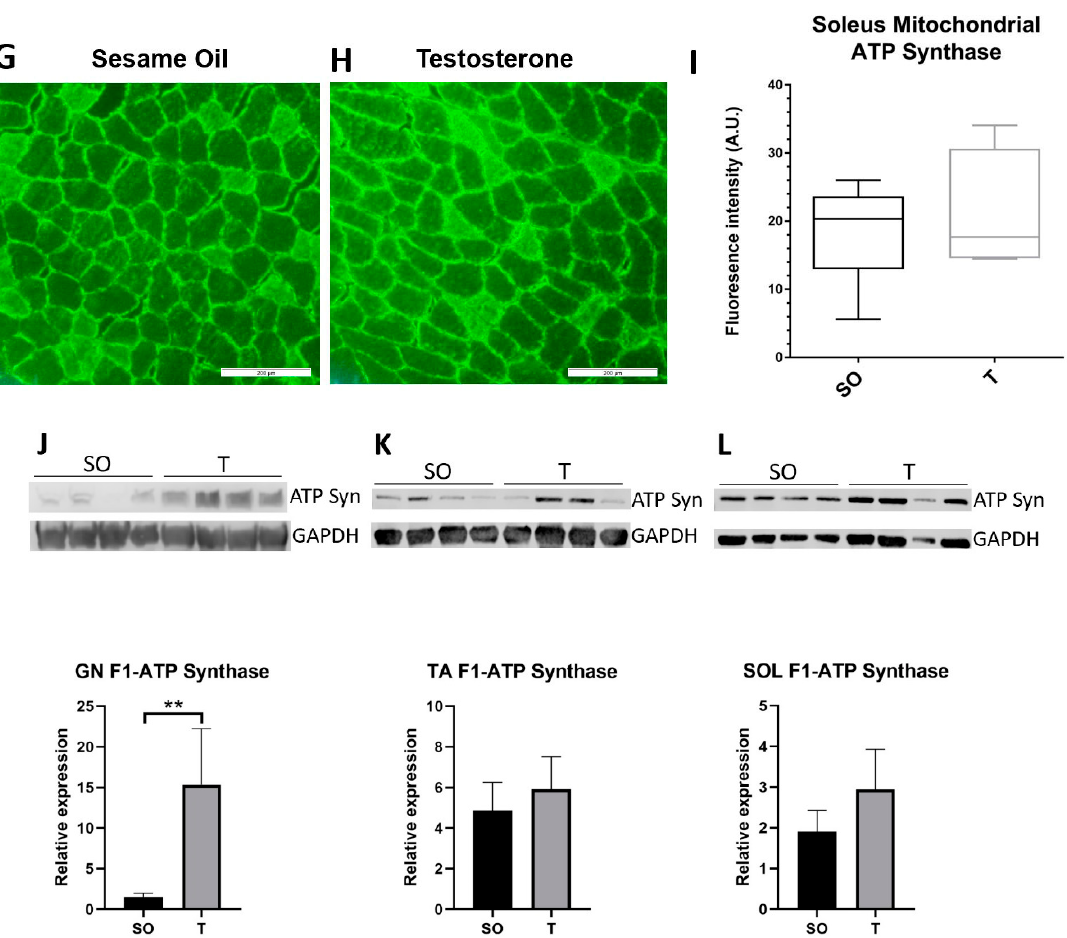
Figure 6. Expression of the mitochondrial marker ATP synthase is higher in gastrocnemius muscle in PNA rats. Gastrocnemius ( A – C ), tibialis anterior ( D – F ), and soleus ( G – I ) skeletal muscles from 16-week-old female rats exposed to sesame oil ( n = 4–5) or testosterone ( n = 4–5) were cryosectioned at 20 µm thickness prior to indirect immunolabeling for ATP synthase. Scale bars, 200 µm. For each rat, 3 distinct fields per muscle sample were imaged and the fluorescence intensity quantified ( C , F , I ). Fluorescence intensity data were analyzed using a Mann–Whitney U test. Fluorescence intensity trended higher in muscles from PNA rats for gastrocnemius (# p = 0.0556), trended slightly lower in TA (# p = 0.0979), but was not significantly different in soleus muscle. Quartiles with the median are shown. ( J – L ) Protein expression was examined by Western blot and quantified by densitometric analysis. Samples of ( J ) GN, ( K ) TA, and ( L ) SOL muscles from rats exposed to sesame oil ( n = 8) or testosterone ( n = 8) were separated by SDS-PAGE and transferred to nitrocellulose prior to detection with antibodies to the alpha subunit of ATP synthase or GAPDH (top panels). Values for ATP synthase were normalized to GAPDH and analyzed using an unpaired t test or Mann–Whitney U test, which indicated significantly greater expression of ATP synthase in GN, but not TA or SOL, from PNA rats (bottom panels). Values shown are means with SD. ** p < 0.005.